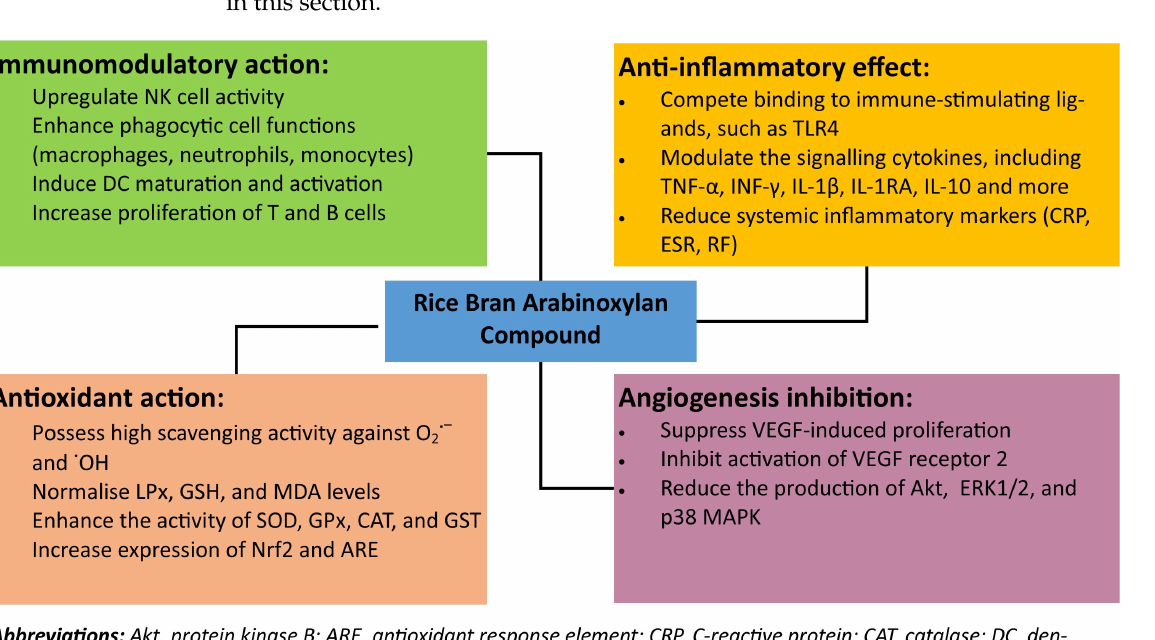
Figure 4. A summary of the key health-promoting attributes of rice bran arabinoxylan